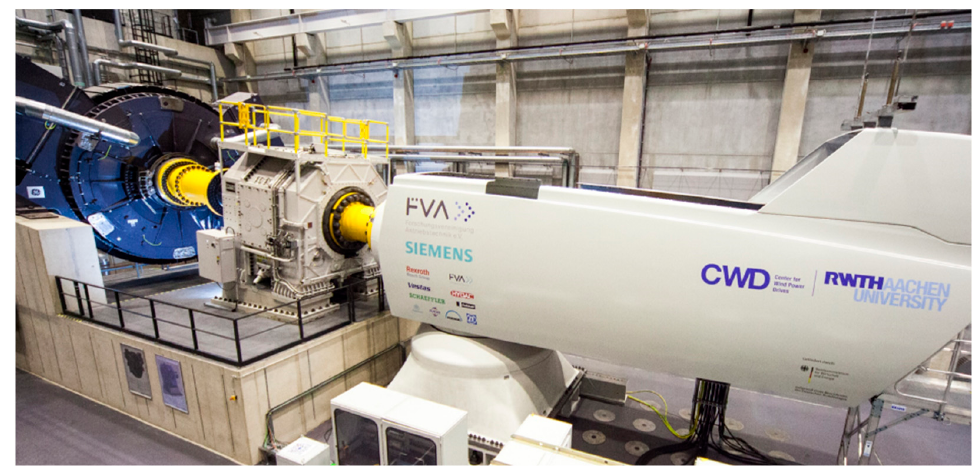
Figure 9. The FVA WT nacelle on test bench.